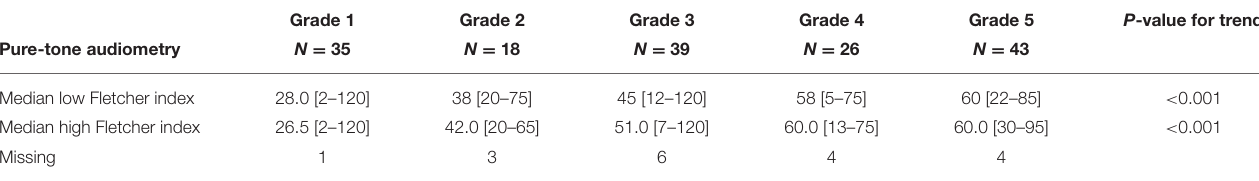
TABLE 8 | Hearing loss in unilateral HED stratified by the summative EH